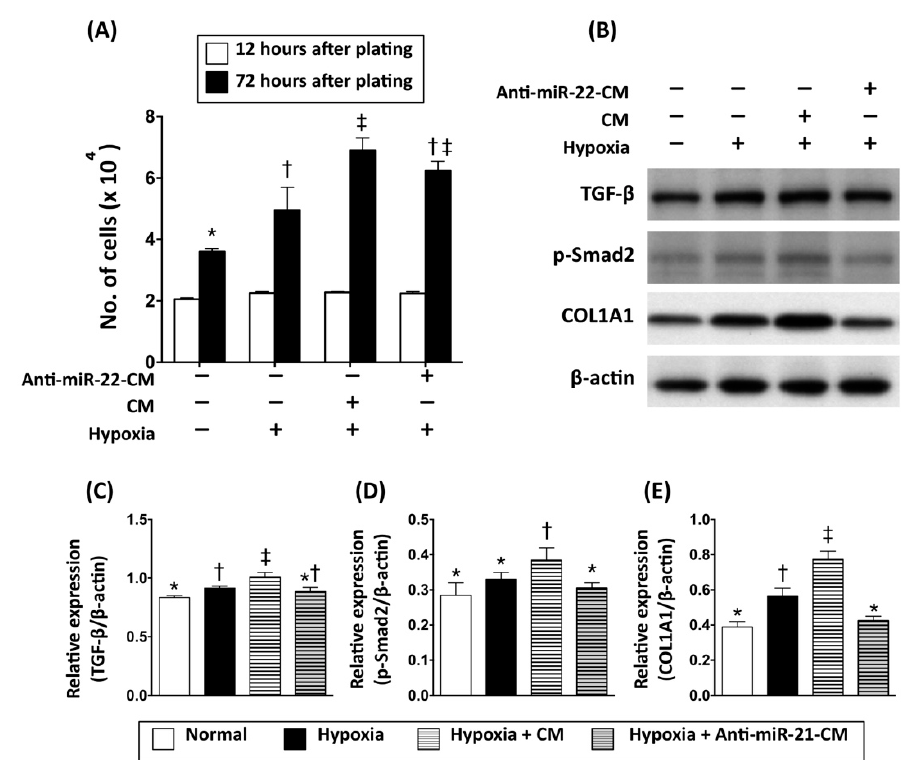
Figure 4. Inhibition of miR-21 reduced the e ff ect of conditioned medium on activation of cardiac fibroblasts. ( A ) Cell number counting to determine the proliferative rate of cardiac fibroblasts incubated with hypoxia (3% O 2 ) and in conditioned medium derived from OGD-treated cardiomyocytes. ( B ) Western blots to examine the expression levels of fibrosis signaling proteins (TGF- β , phosphorylated Smad2) and collagen deposition (collagen typ1 1 alpha 1, COL1A1) in primary cardiac fibroblasts incubated with hypoxia and in conditioned medium derived from OGD-treated cardiomyocytes. ( C ) Quantitative data represent the ratio of TGF- β expression to β -actin expression. ( D ) Quantitative data represent the ratio of phosphorylated Smad2 to β -actin expression. ( E ) Quantitative data represent the ratio of COL1A1 to β -actin expression. CM, conditioned medium derived from OGD-treated cardiomyocytes. Anti-miR-21-CM, conditioned medium derived from cardiomyocytes pre-transfected with Anti-miR-21 (20 nM). Groups with di ff erent symbols (*, † , ‡ ), p < 0.05. n = 6 for each group.